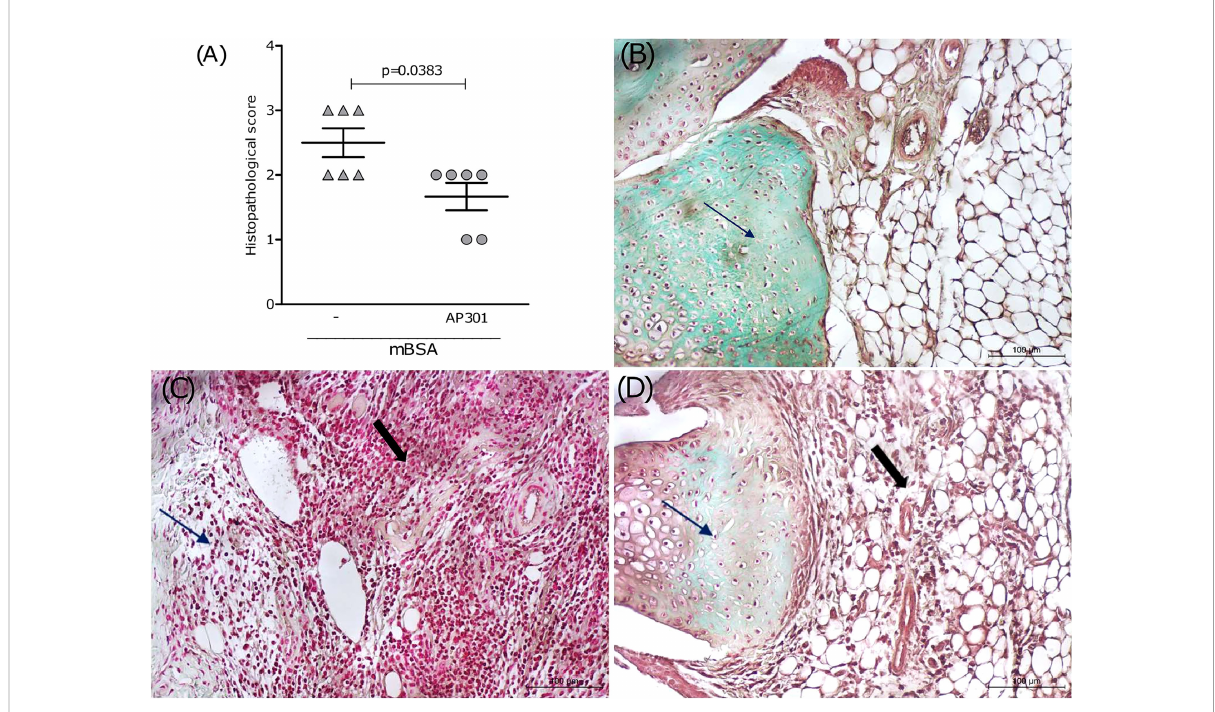
FIGURE 4 Mice subjected to mBSA arthritis received i.art. solnatide (AP 301) or saline ( − ) 2 days after challenge with mBSA being sacri fi ced after 24 h; (A) score (medians) of HE-stained whole joints compared using Mann – Whitney. Representative illustrations of synovium and cartilage (arrows)